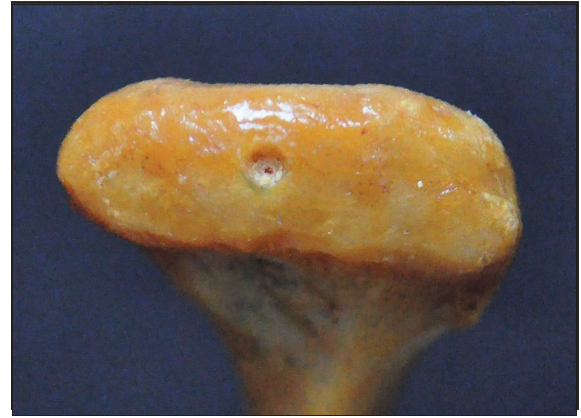
Figure 1 - Example of a medium defect created in the su- perior surface of the